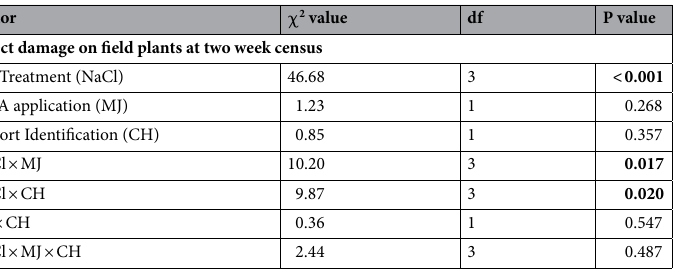
Table 2. Results from linear mixed models testing for the effect of salt treatment in the soil, Methyl Jasmonate (MeJa) application, cohort identification and their interactions on feeding consumption by the generalist herbivore Spodoptera exigua on tomato ( Solanum lycoperscium ) plants after two weeks in a field common garden.